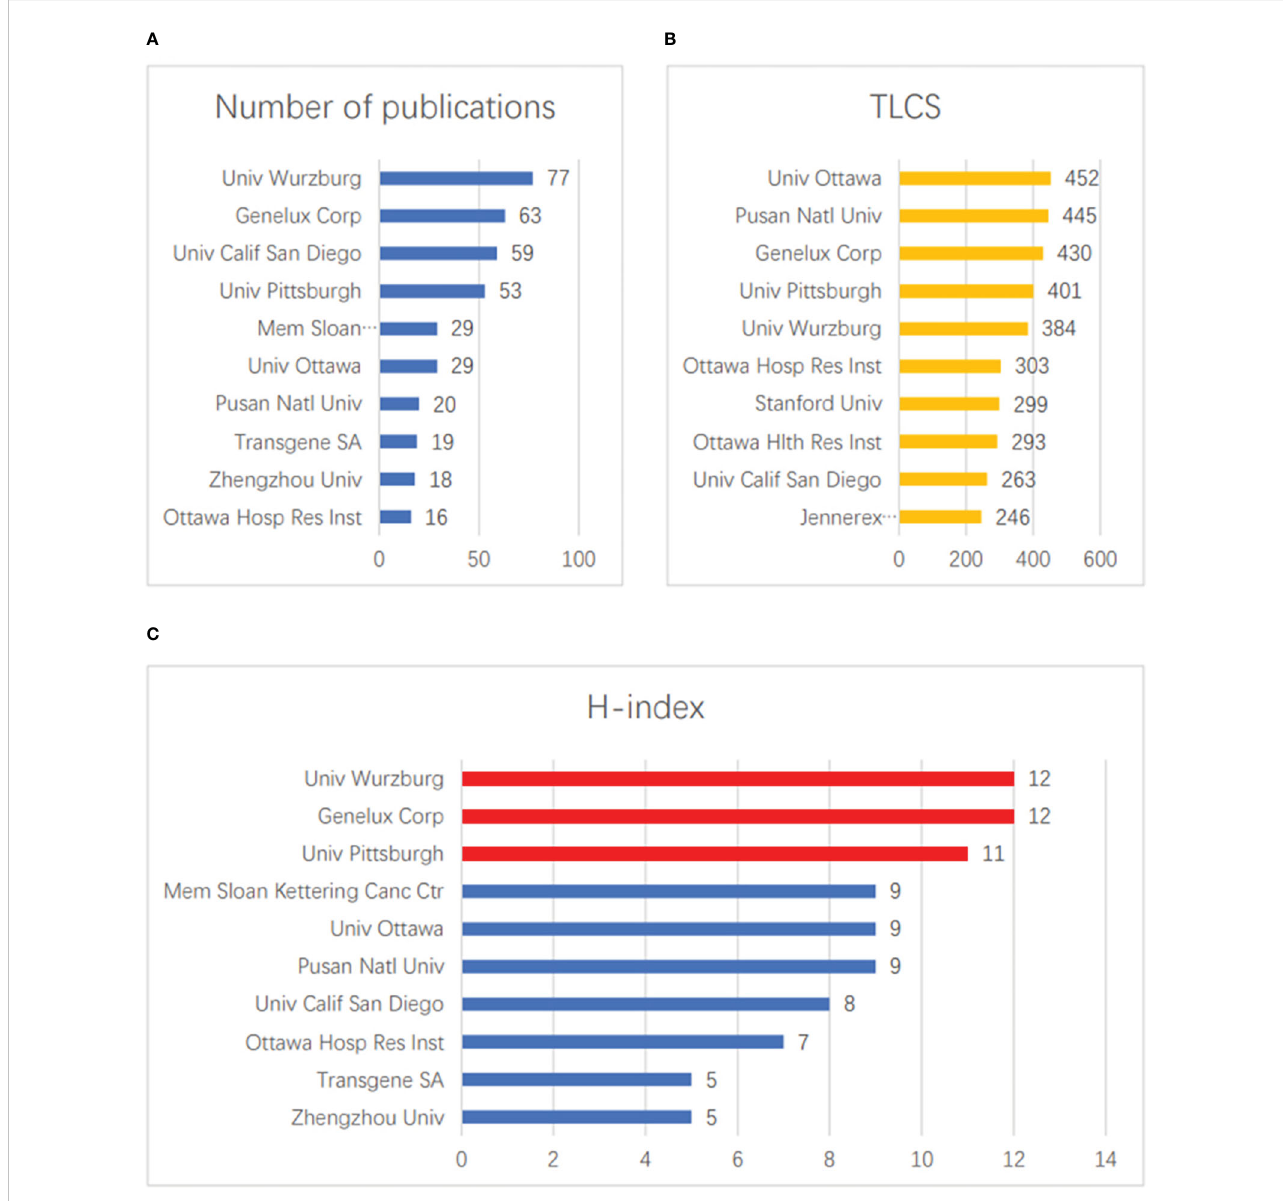
FIGURE 4 Contributions of institution. (A) The top 10 institutions in terms of total publication volume. (B) The top 10 institutions in terms of total LCS. (C) The top 10 institutions with the largest H-index